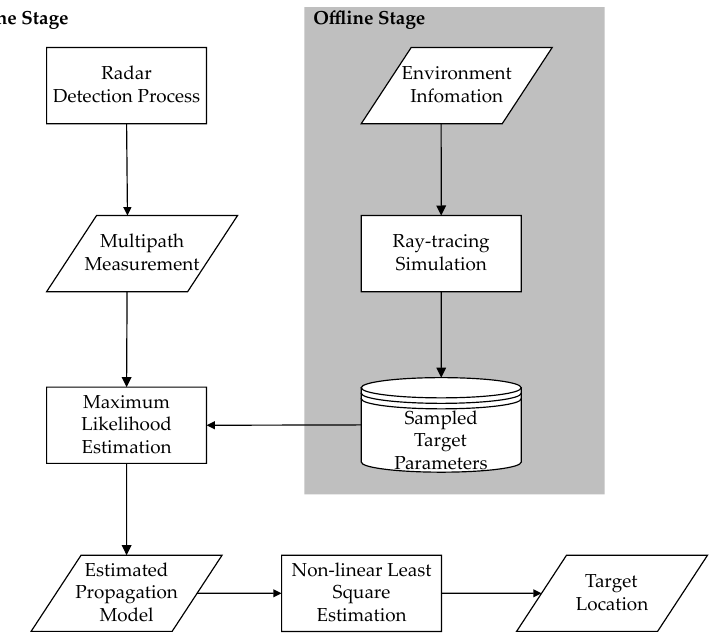
Figure 2. Framework of the proposed target localization